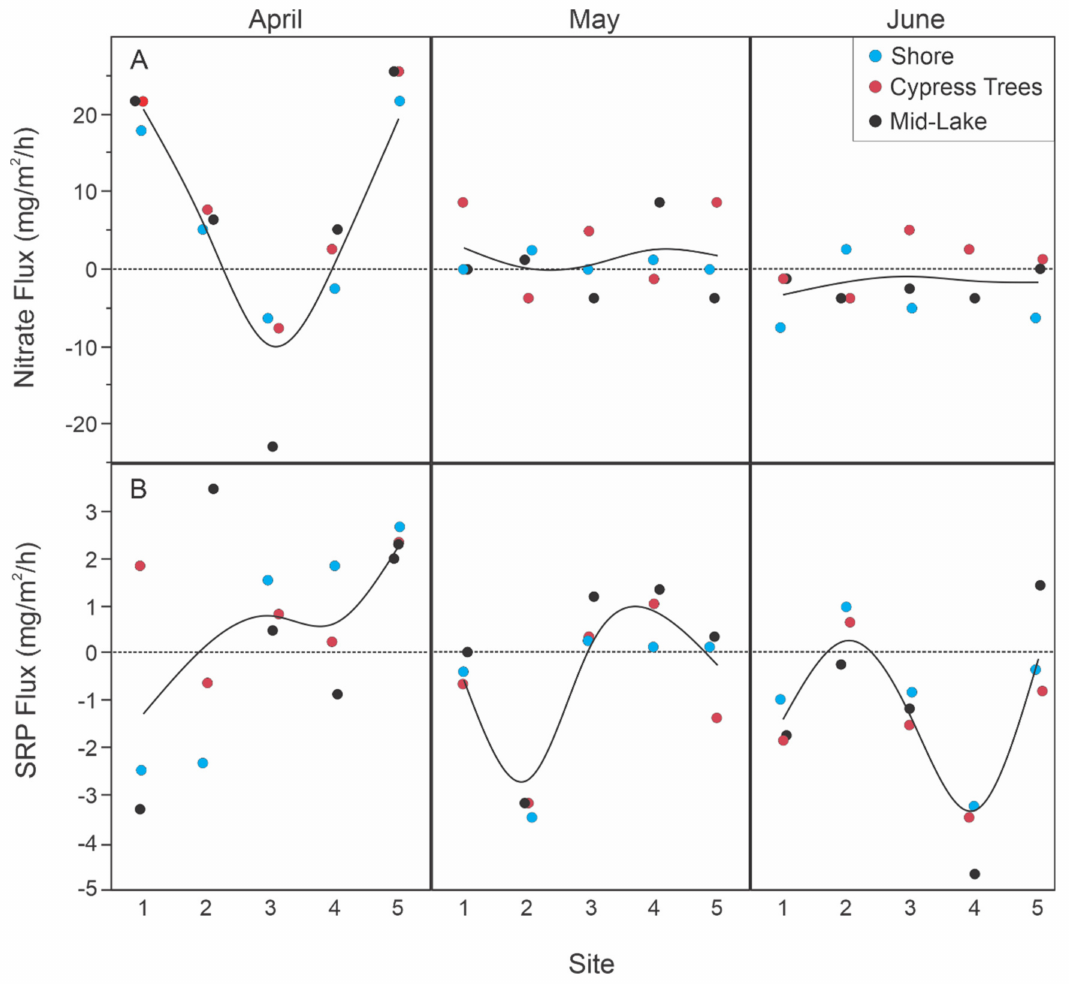
Figure 4. Sediment core ( A ) nitrate and ( B ) soluble reactive phosphate (SRP) flux rates by site across months in Roundaway Lake, MS. Points are coded by depth habitat (mid-lake, green circles; edge of bald cypress ( Taxodium distichum (L.) Rich.) trees, red circles; or near shore, blue circles). Negative values indicate a movement of nitrate or SRP from the water to the sediments and positive values indicate a nitrate or SRP release from the sediments into the